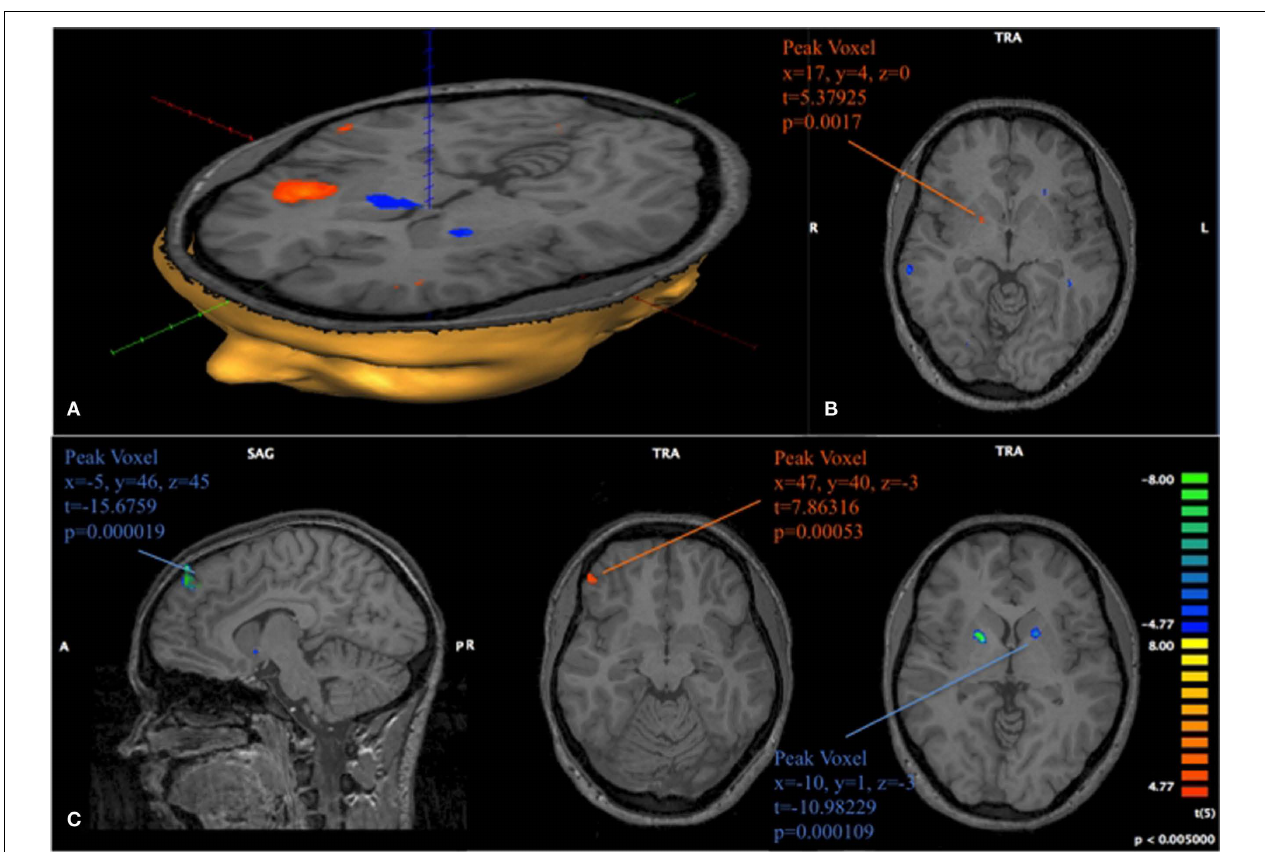
more strongly negative activation at position 11 in late periods for Slow learning subject. (C) 12 predictor GLM for 6 subjects classified as Fast Learners. As in (B) , we show the subtraction of the contrast (11 early-1, 2 early)–(11 late-1, 2).We find activation in Medial Prefrontal Gyrus (MPFG),VLPFC, and Striatum. Negative identification in Striatum is driven by a more strongly negative response at position 11 during early trials for Fast Learners. p < 0.005 uncorrected for all images depicted here.